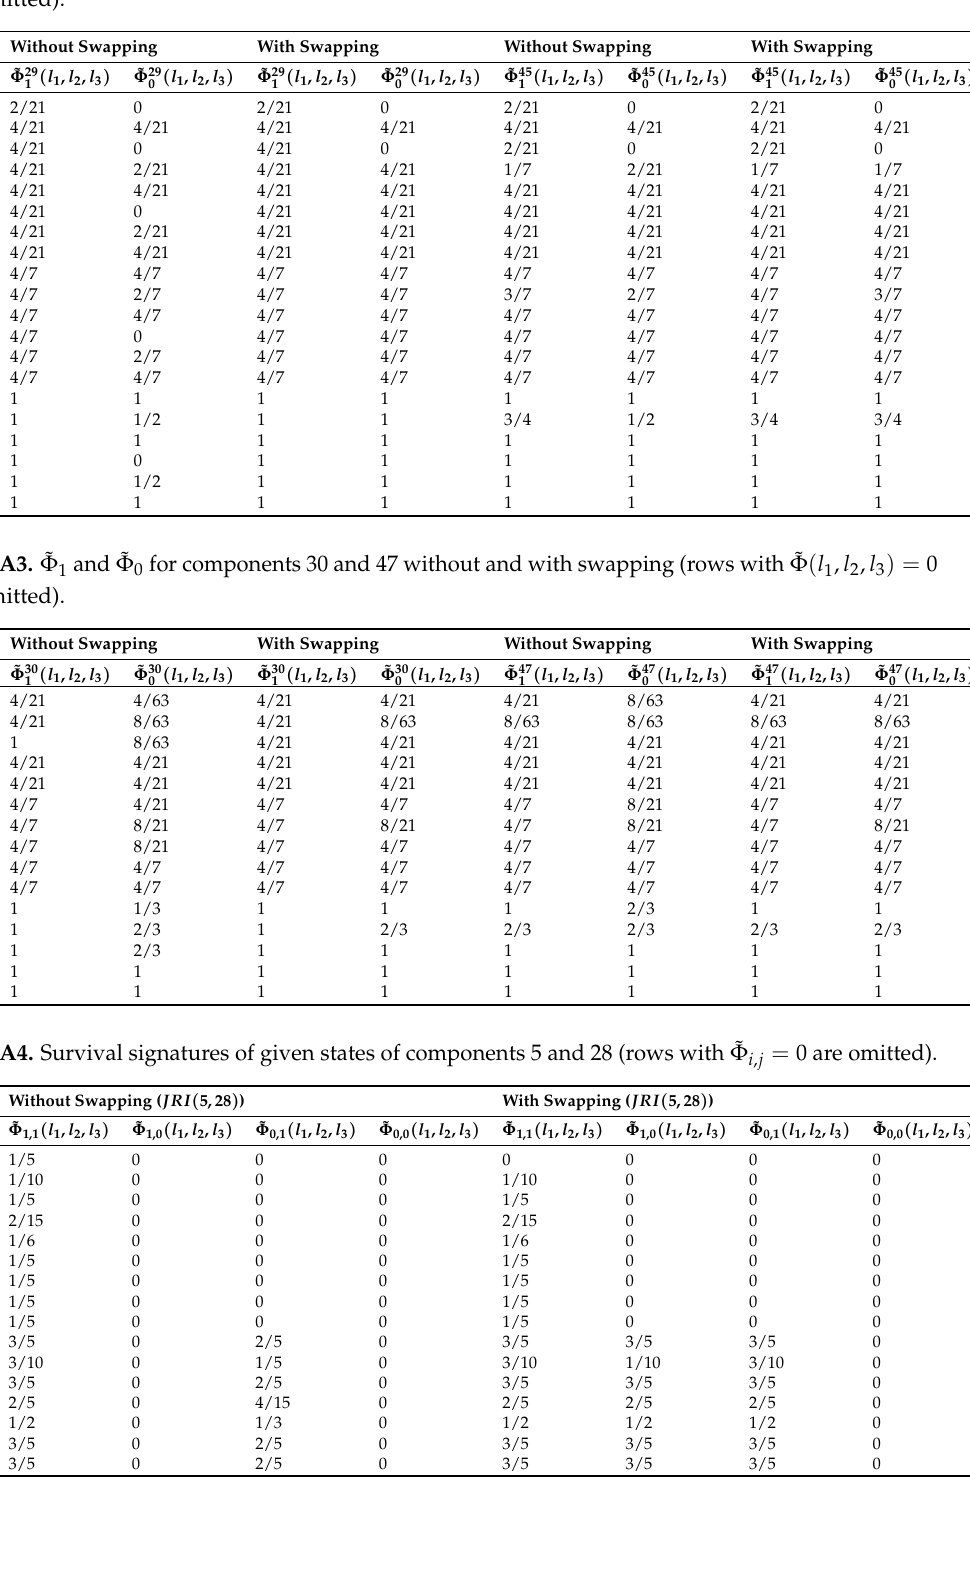
Table A2. ˜ Φ 1 and ˜ Φ 0 for components 29 and 45 without and with swapping (rows with ˜ Φ ( l 1 , l 2 , l 3 ) = 0 are omitted).